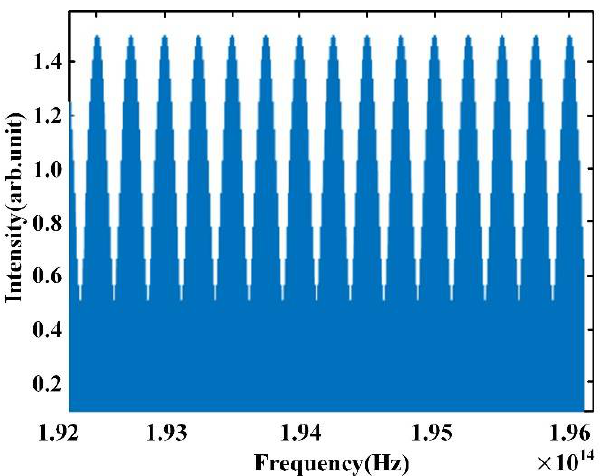
Figure 2. Spectrum of dispersive interferometry.